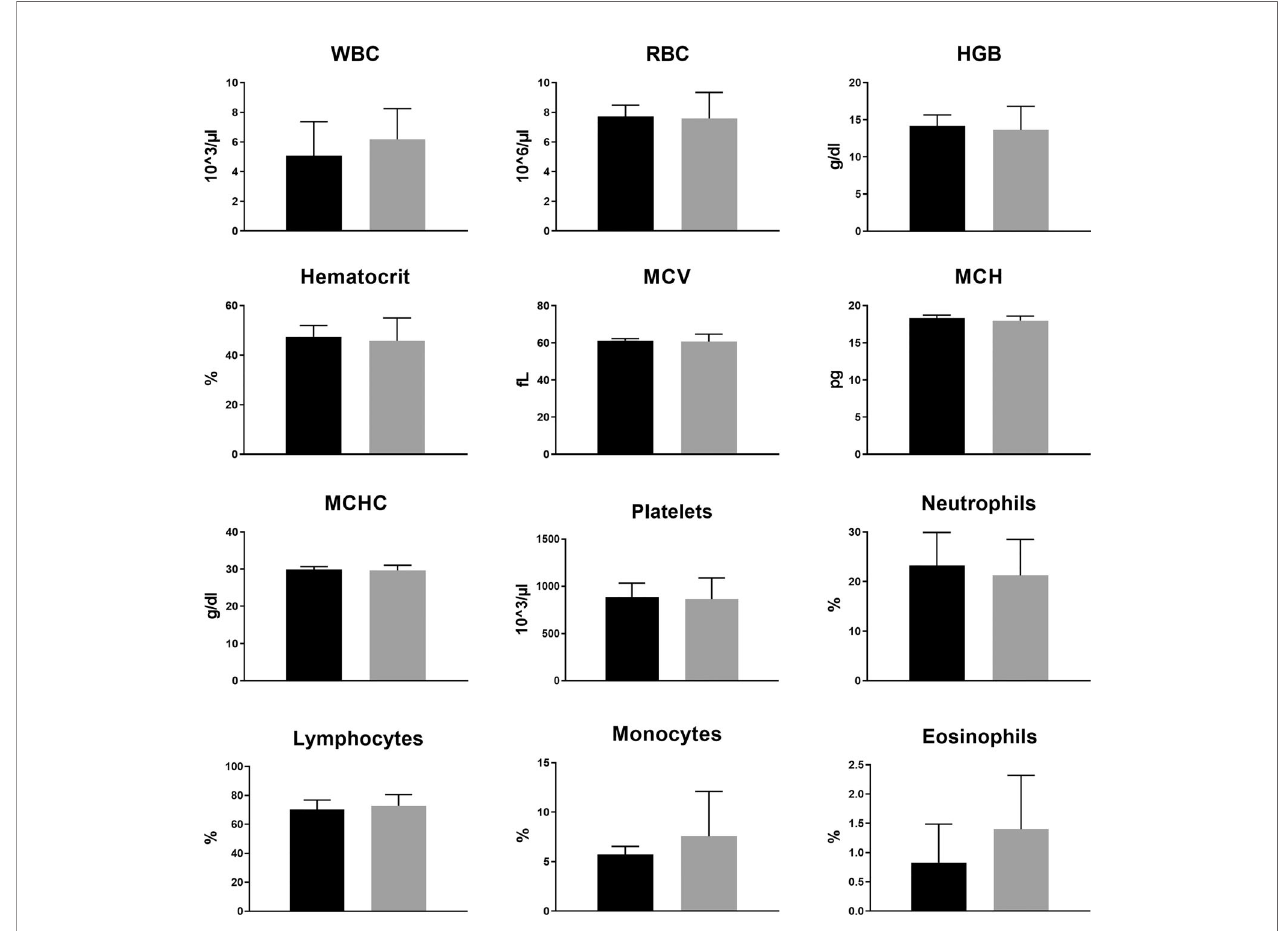
FIGURE 3 | Animal complete blood count (CBC) at the end of 2 weeks of sham or 200 kHz TTFields application. Average ± standard deviations at study end are shown for control animals versus animals treated with TTFields. TTFields vs control non-signi fi cant; Student ’ s t-test. (WBC, white blood cells; RBC, red blood cells; HGB, hemoglobin; MCV, mean corpuscular volume; MCH, mean corpuscular hemoglobin; MCHC, MCH